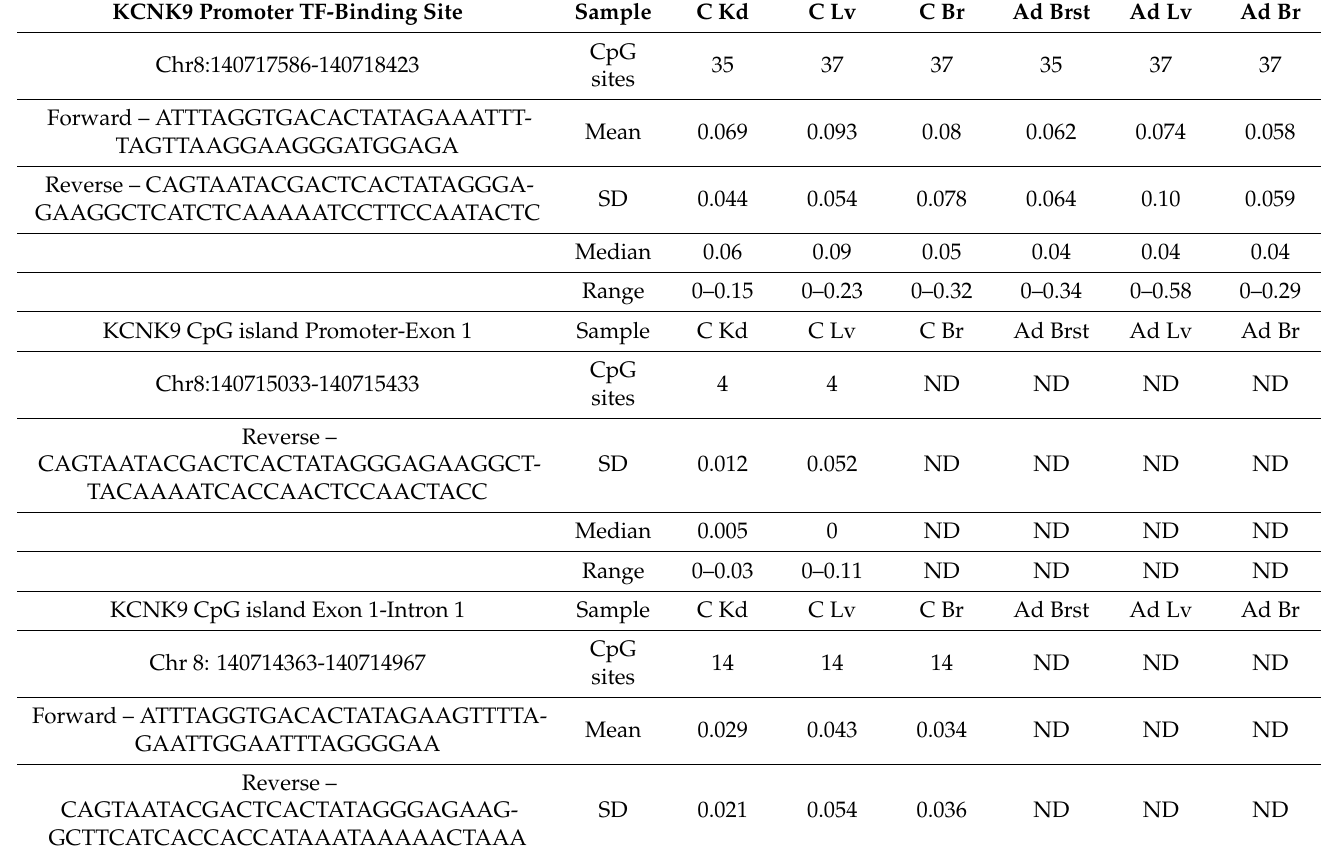
Table A1. Methylation levels for CpG sites in the KCNK9 promoter CpG